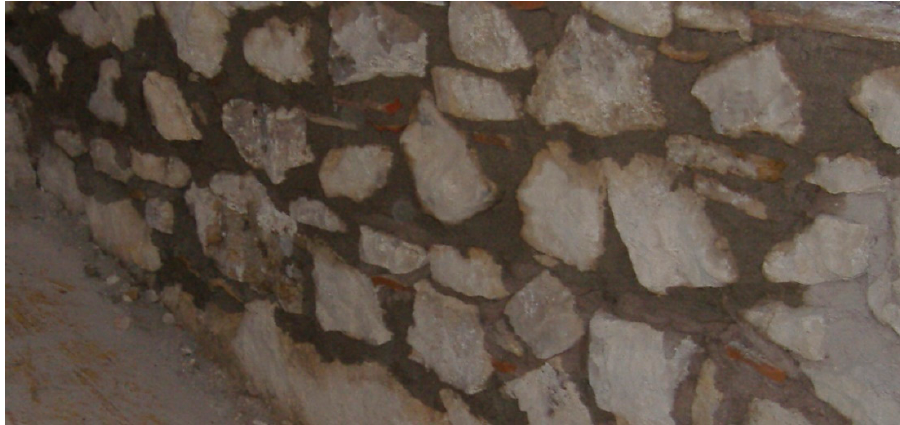
Figure 8. Application of the indentation technique: strengthening of uncoursed rubble masonry wall.